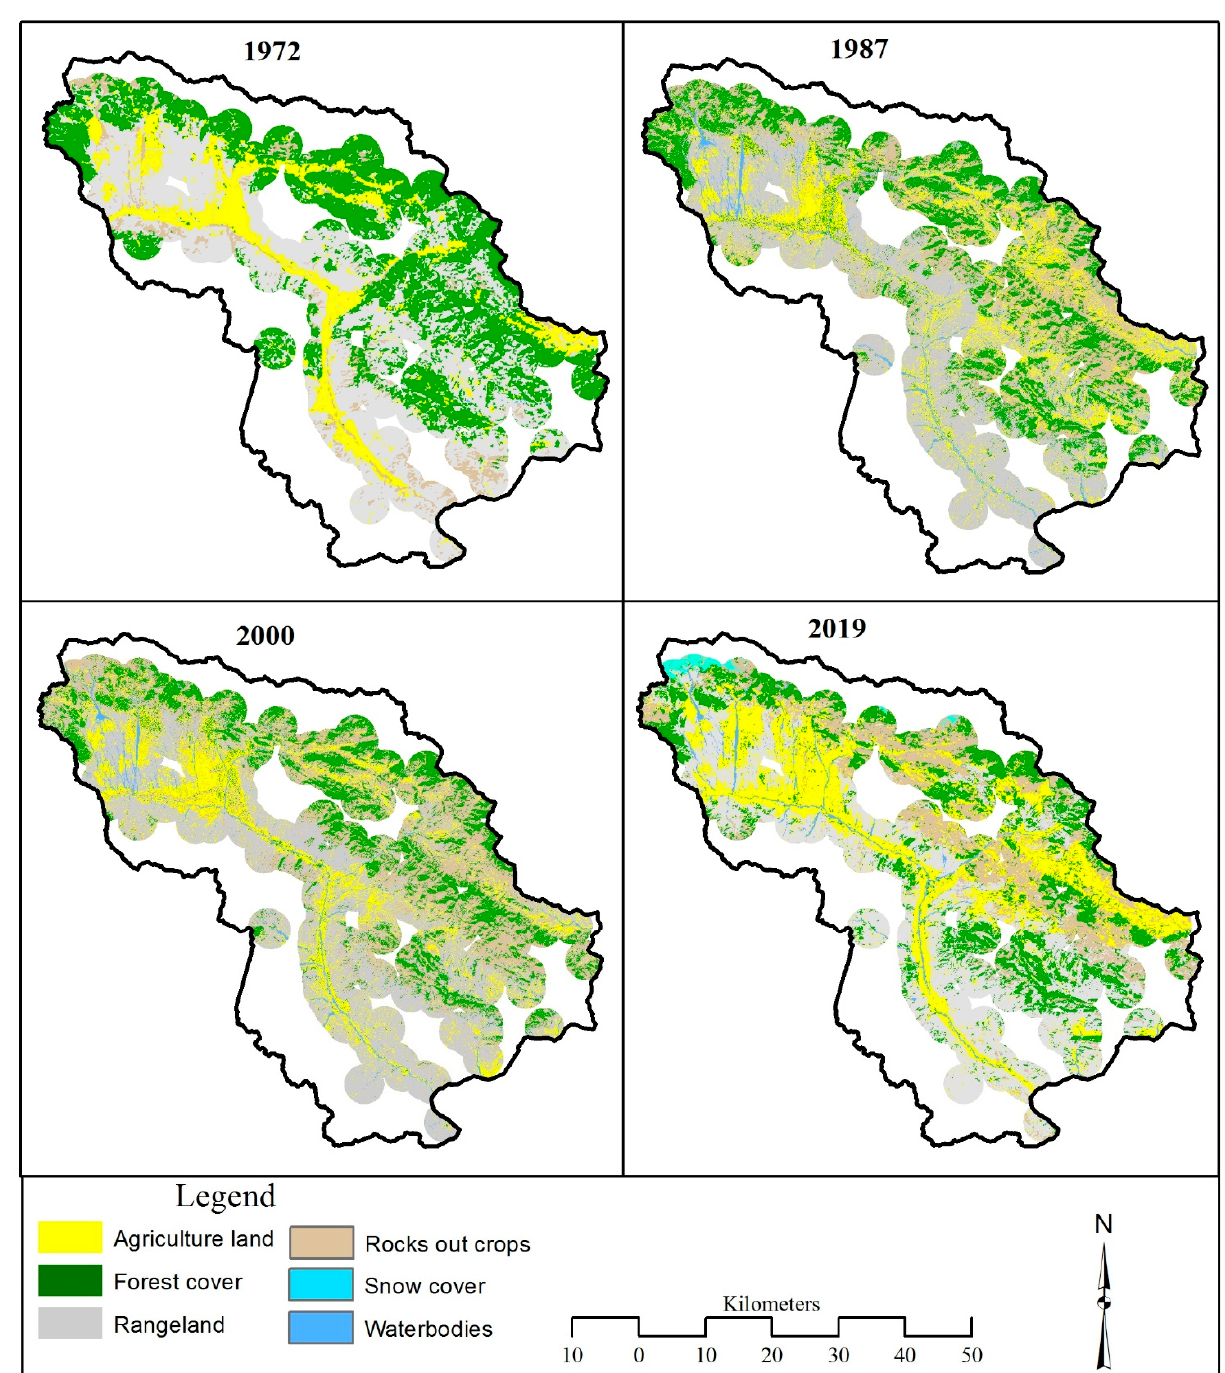
Figure 6. Land use and land cover around 3 km of refugee camps.